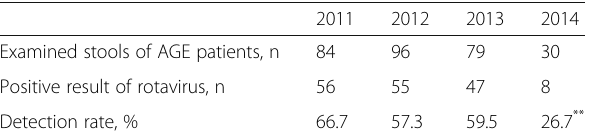
Table 3 Detection numbers and rates of rotavirus in AGE patients during the rotavirus